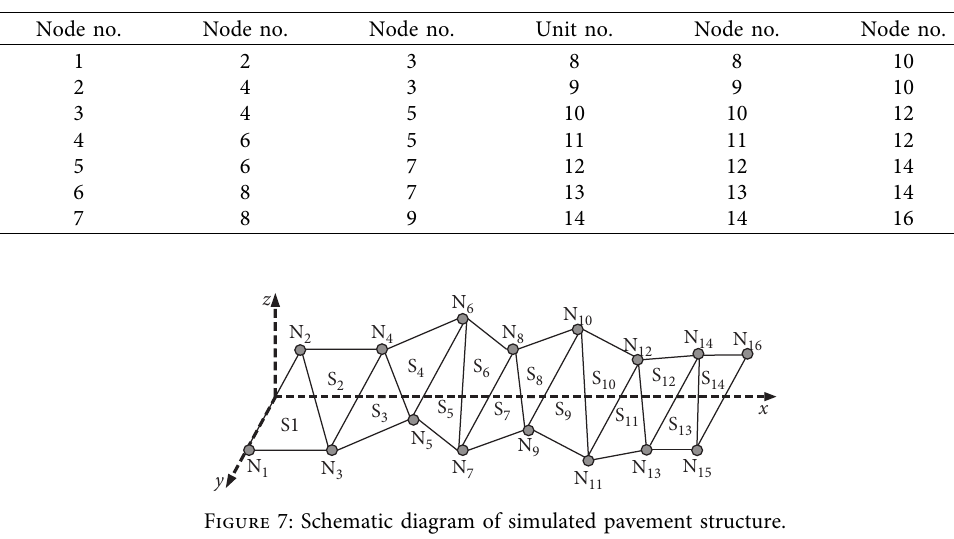
Table 5: List of simulated pavement units.